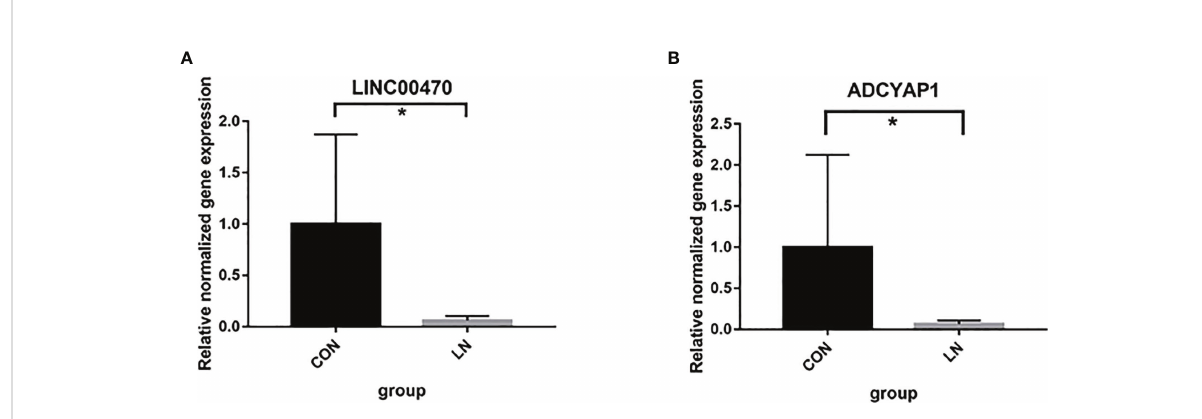
FIGURE 2 mRNA expression of LINC00470 (A) and ADCYAP1 (B) in PBMCs of 6 LN patients and 6 healthy controls assessed by qRT-PCR. * P<0.05